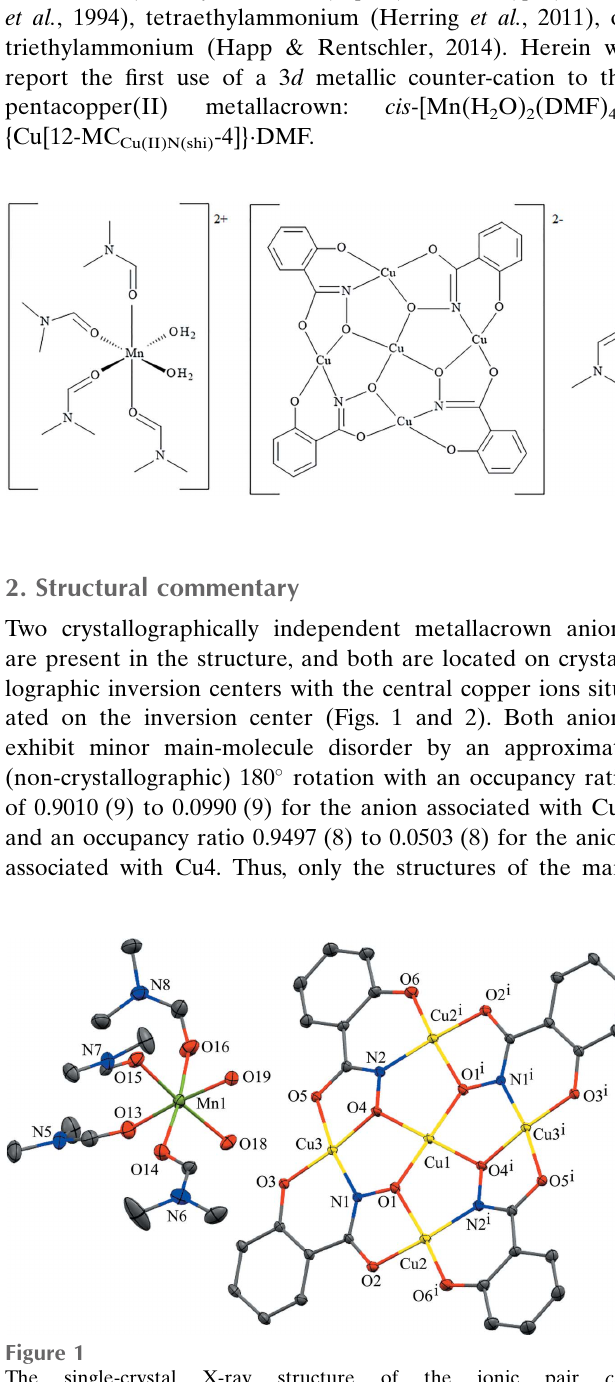
Figure 2 The single-crystal X-ray structure of {Cu[12-MC Cu(II)N(shi) -4]} 2 (cid:3) asso- ciated with Cu4 with displacement ellipsoids at the 50% probability level [symmetry code: (ii) 1 (cid:3) x , (cid:3) y , 1 (cid:3) z ]. For clarity, only non-carbon atoms have been labeled, and the MC associated with Cu1, the Mn II counter- cation, the lattice DMF molecule, H atoms, and disorder have been omitted. See Fig. 1 for additional display details.